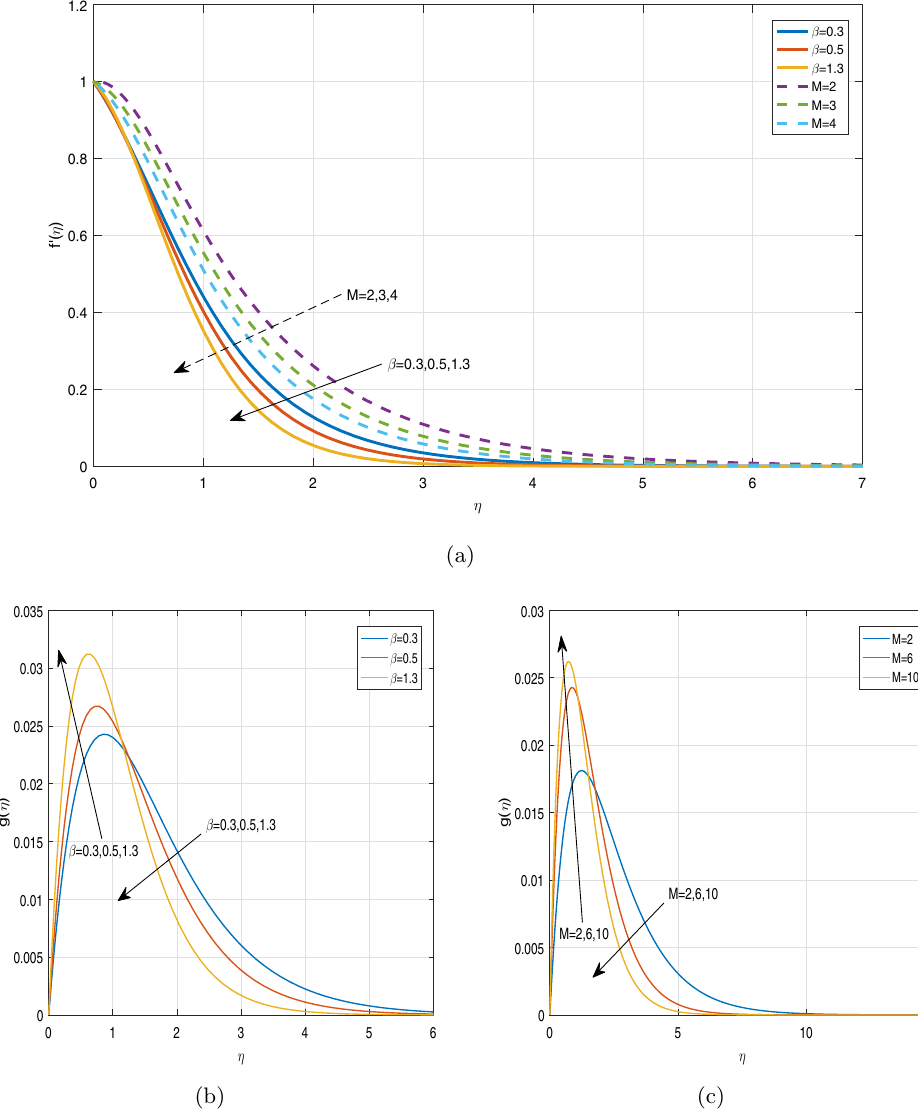
Figure 3. Graphs of ( a ) f ′ (η) against β and M , ( b ) g (η) against β , ( c ) g (η) against M